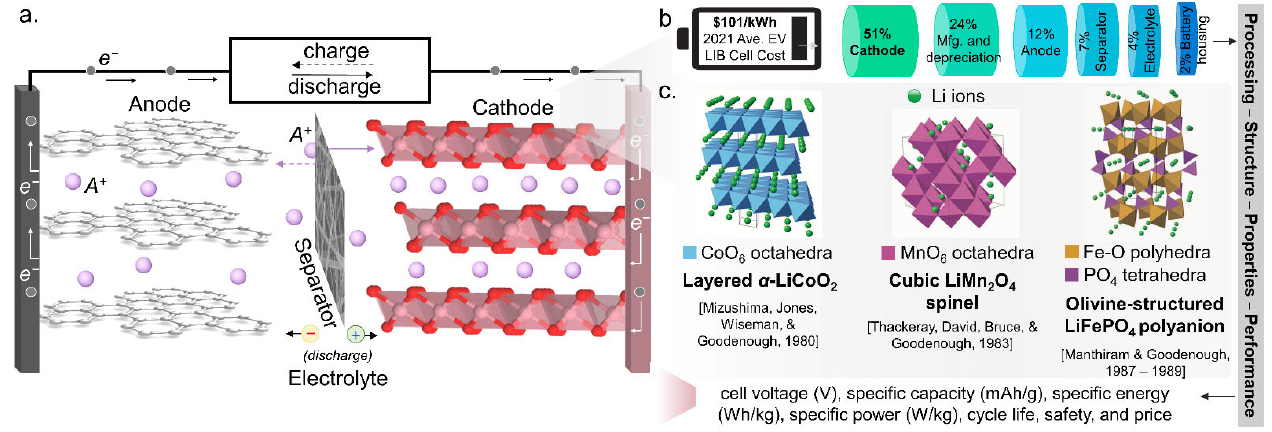
Figure 1. Background and motivation development for secondary battery cathode research: ( a ) schematic diagram of secondary battery principle of operation; ( b ) cost segmentation of electric vehicle lithium ‐ ion battery as of 2021. [3]; and ( c ) conventional cathode materials of the three oxide cathode classifications (Adapted with permission from Ref. [4]. Copyright 2014, The Royal Society of Chemistry). Integral is the foundational understanding of the processing–structure–properties–performance relationship of the cathode materials for the rational design of cost ‐ effective secondary batteries for the intended scale of application.